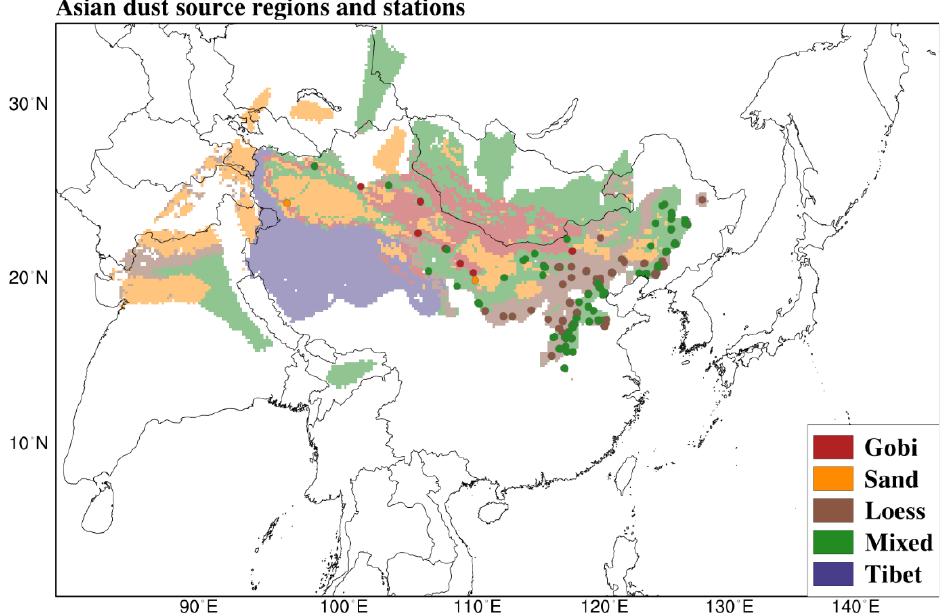
Figure 1. Spatial distribution of 262 observation sites (colored circles) and surface soil types (Gobi, sand, loess, mixed, and Tibetan) over the Asian dust source regions of the Asian Dust Aerosol Model 3 (ADAM3) (based on Figure 1 of Park and In, 2003).